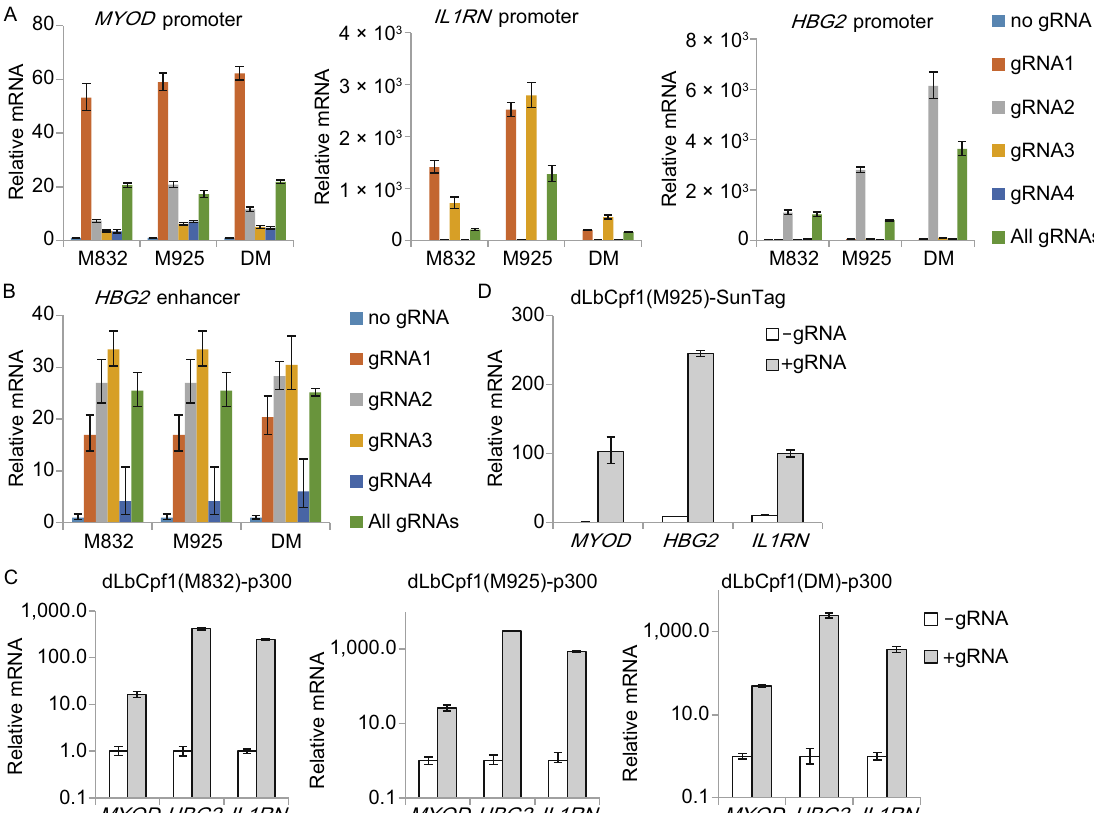
Figure 2. Simultaneously transcriptional activation of multiple endogenous genes using either dLbCpf1-p300core or dLbCpf1-SunTag system with a single gRNA for each gene . (A) Relative mRNA expression of MYOD , IL1RN , and HBG2 revealed by quantitative real-time PCR, in HEK293Tcells co-transfected with dCpf1-p300core fusion proteins and four single gRNAs or pooled sets of all four single gRNAs targeting each promoter region of target genes. (B) Relative mRNA expression of HBG2 revealed by quantitative RT-PCR, in HEK293Tcells co-transfected with dCpf1-p300core fusion proteins and four single gRNAs or pooled sets of all four single gRNAs targeting the enhancer region (HS2 region) of HBG2 gene. (C) Relative mRNA expression of MYOD , HBG2 , and IL1RN revealed by quantitative RT-PCR, in HEK293Tcells co-transfected with dCpf1-p300core fusion proteins and three gRNAs targeting each promoter region of target genes. (D) Relative mRNA expression of MYOD , HBG2 , and IL1RN revealed by quantitative RT-PCR, in HEK293T cells co-transfected with dLbCpf1 (M925)-SunTag and three gRNAs targeting each promoter region of target genes. For C and D, gRNA1, gRNA2 and gRNA1 were used for MYOD , HBG2 and IL1RN , respectively. For (A – D), mean value are presented with S.D. ( n = 3). Tukey-test, P < 0.05 compared to cells transfected with dCpf1-p300core or dLbCpf1(M925)-SunTag only, n = 3 independent